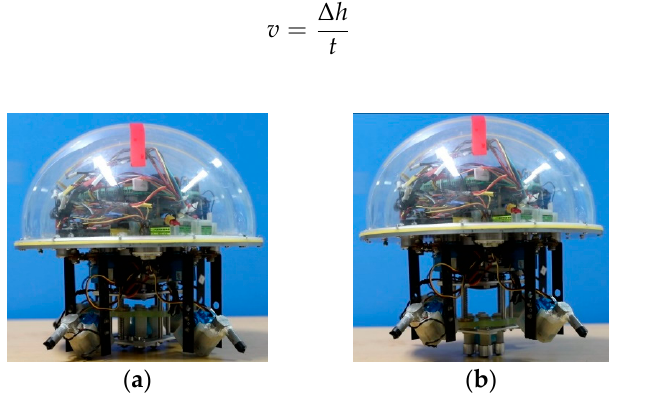
Figure 9. ( a ) The upper state of lifting and supporting wheel mechanism (LSWM); ( b ) the lower state of LSWM.